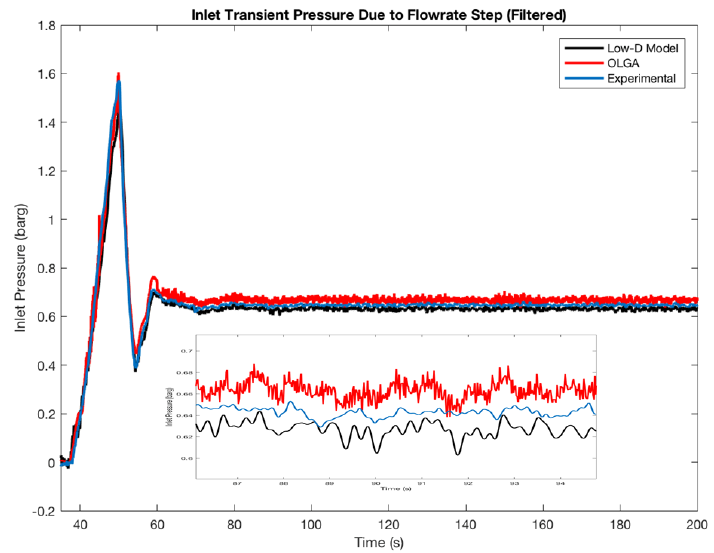
Figure 14. Experimental vs. simulations (Inlet Pressure, liquid with entrained air/case 1).